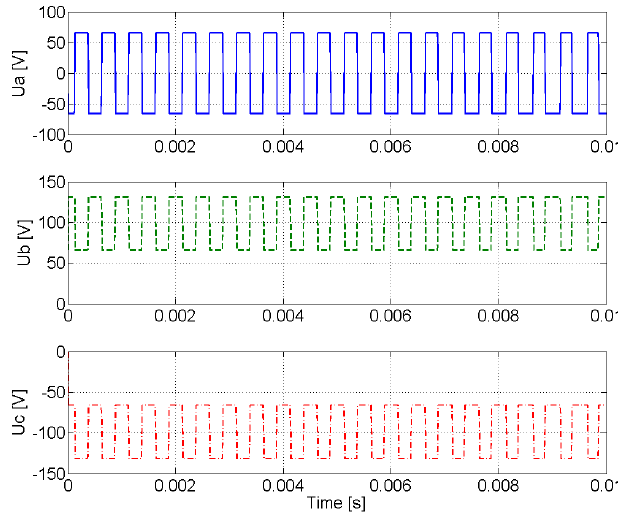
Fig. 16. Phase voltages from the Simulink model, a close-up in Fig. 12. Comparing to Fig. 14 does not show any difference therefore it can be concluded, that the coupling of the excitation functions properly.